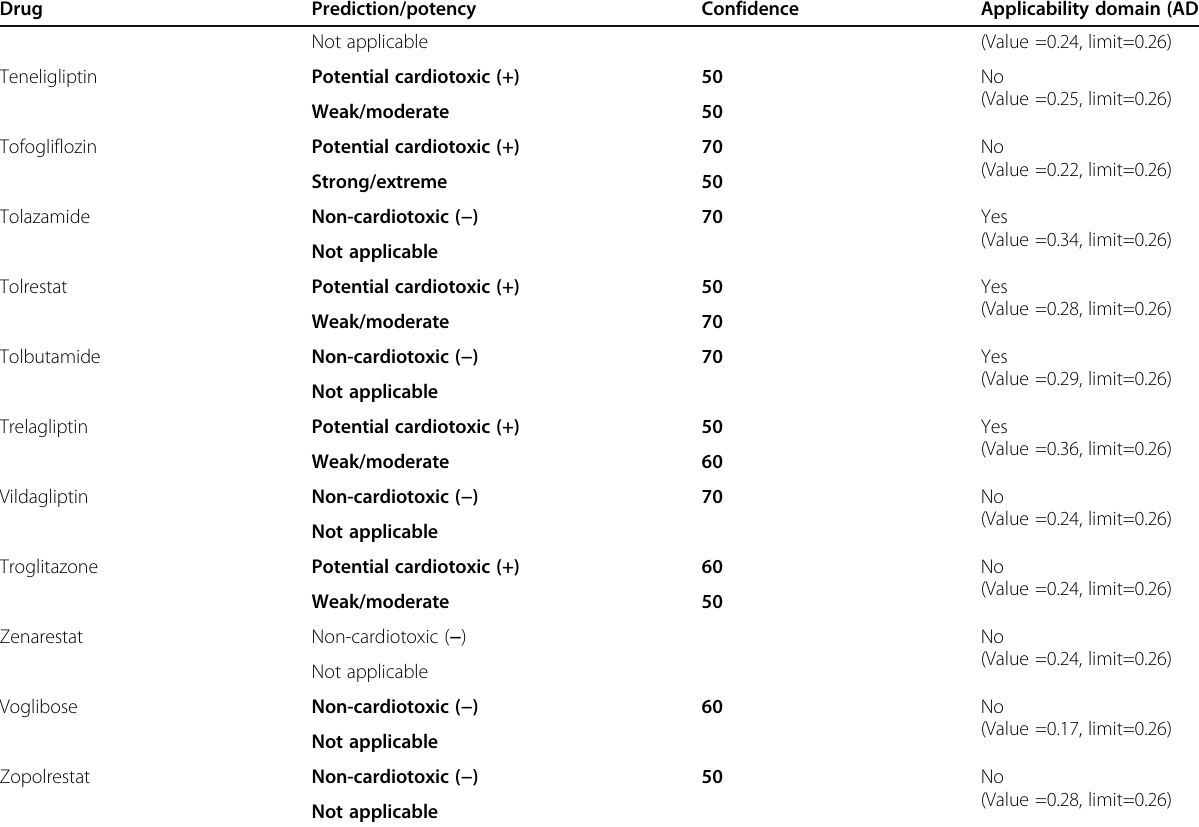
Table 1 Details of anti-diabetic compounds selected for study and their hERG blocking profile (Continued) Drug